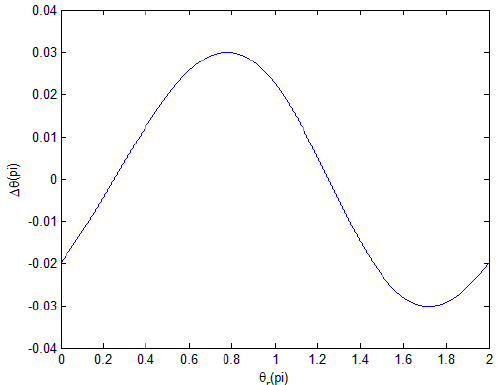
θ Δ in one period of